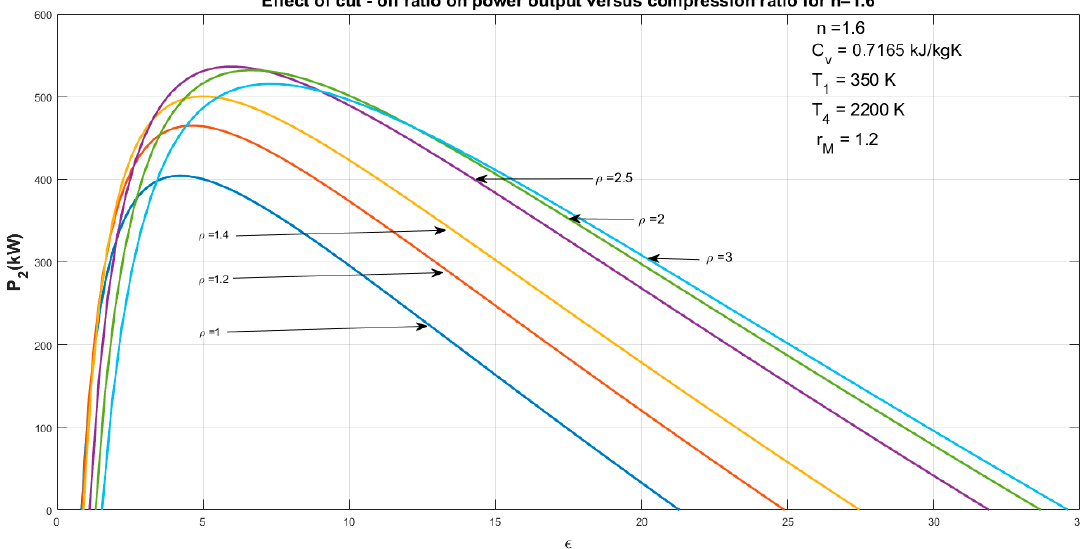
Figure 7. Effect of ρ on P 2 against ε ( n = 1.6).